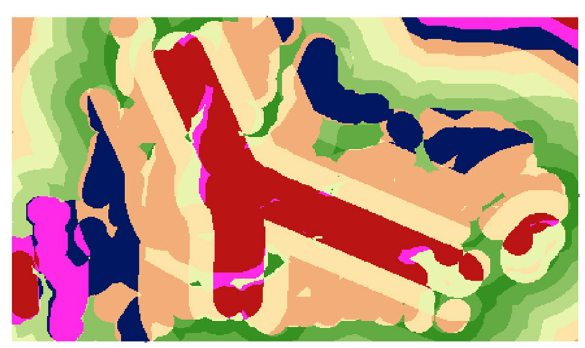
Figure 9. Weighted overlay for layers.